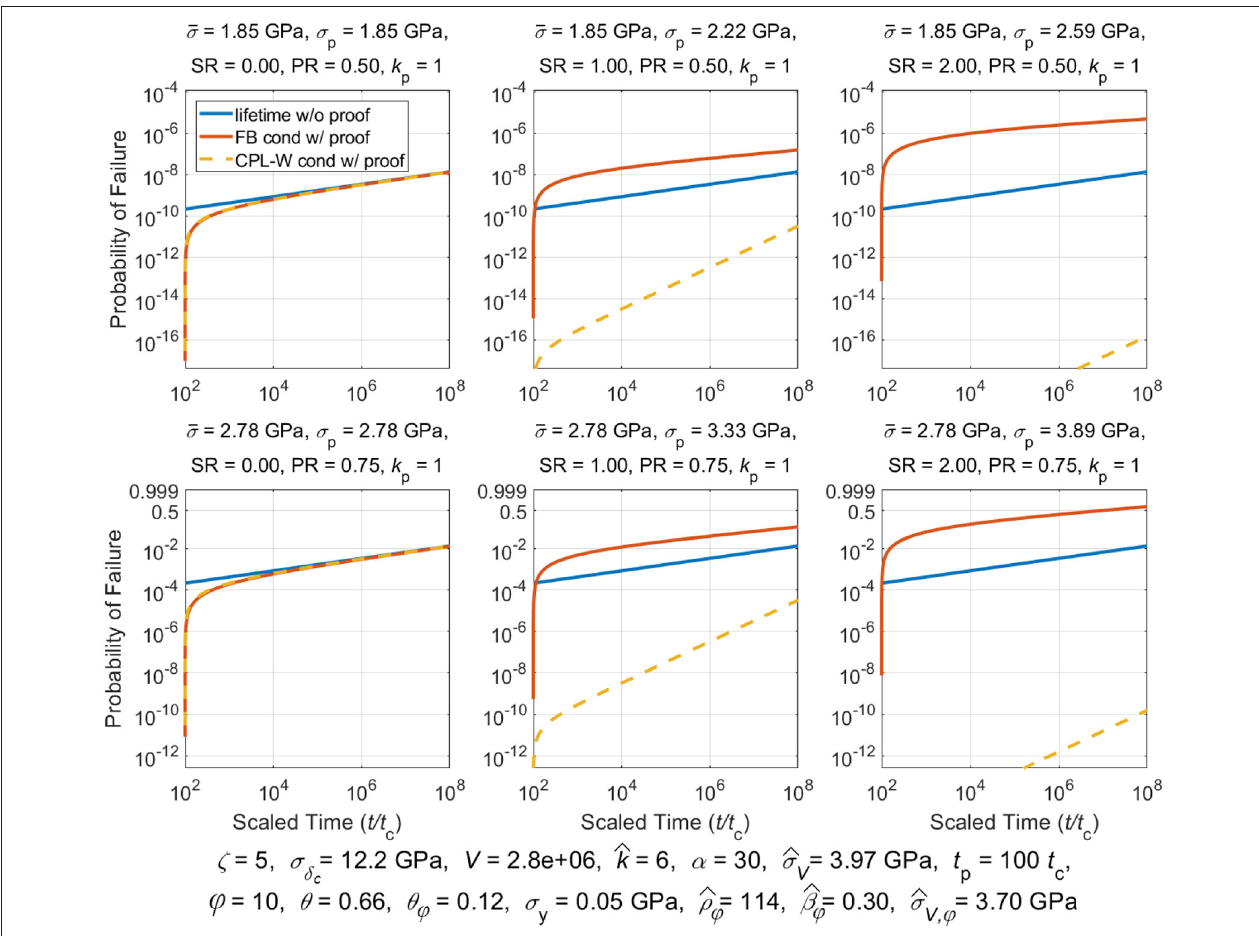
FIGURE 3 | Tows with fibers in a planar array and matrix parameters ϕ